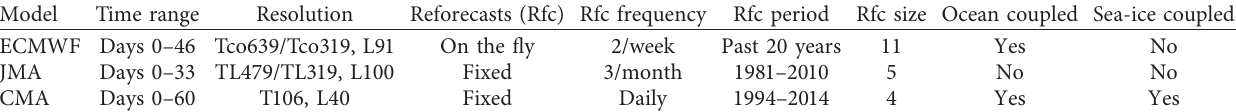
Table 1: The main hindcast (reforecast) feature of ECMWF, JMA, and CMA S2S models